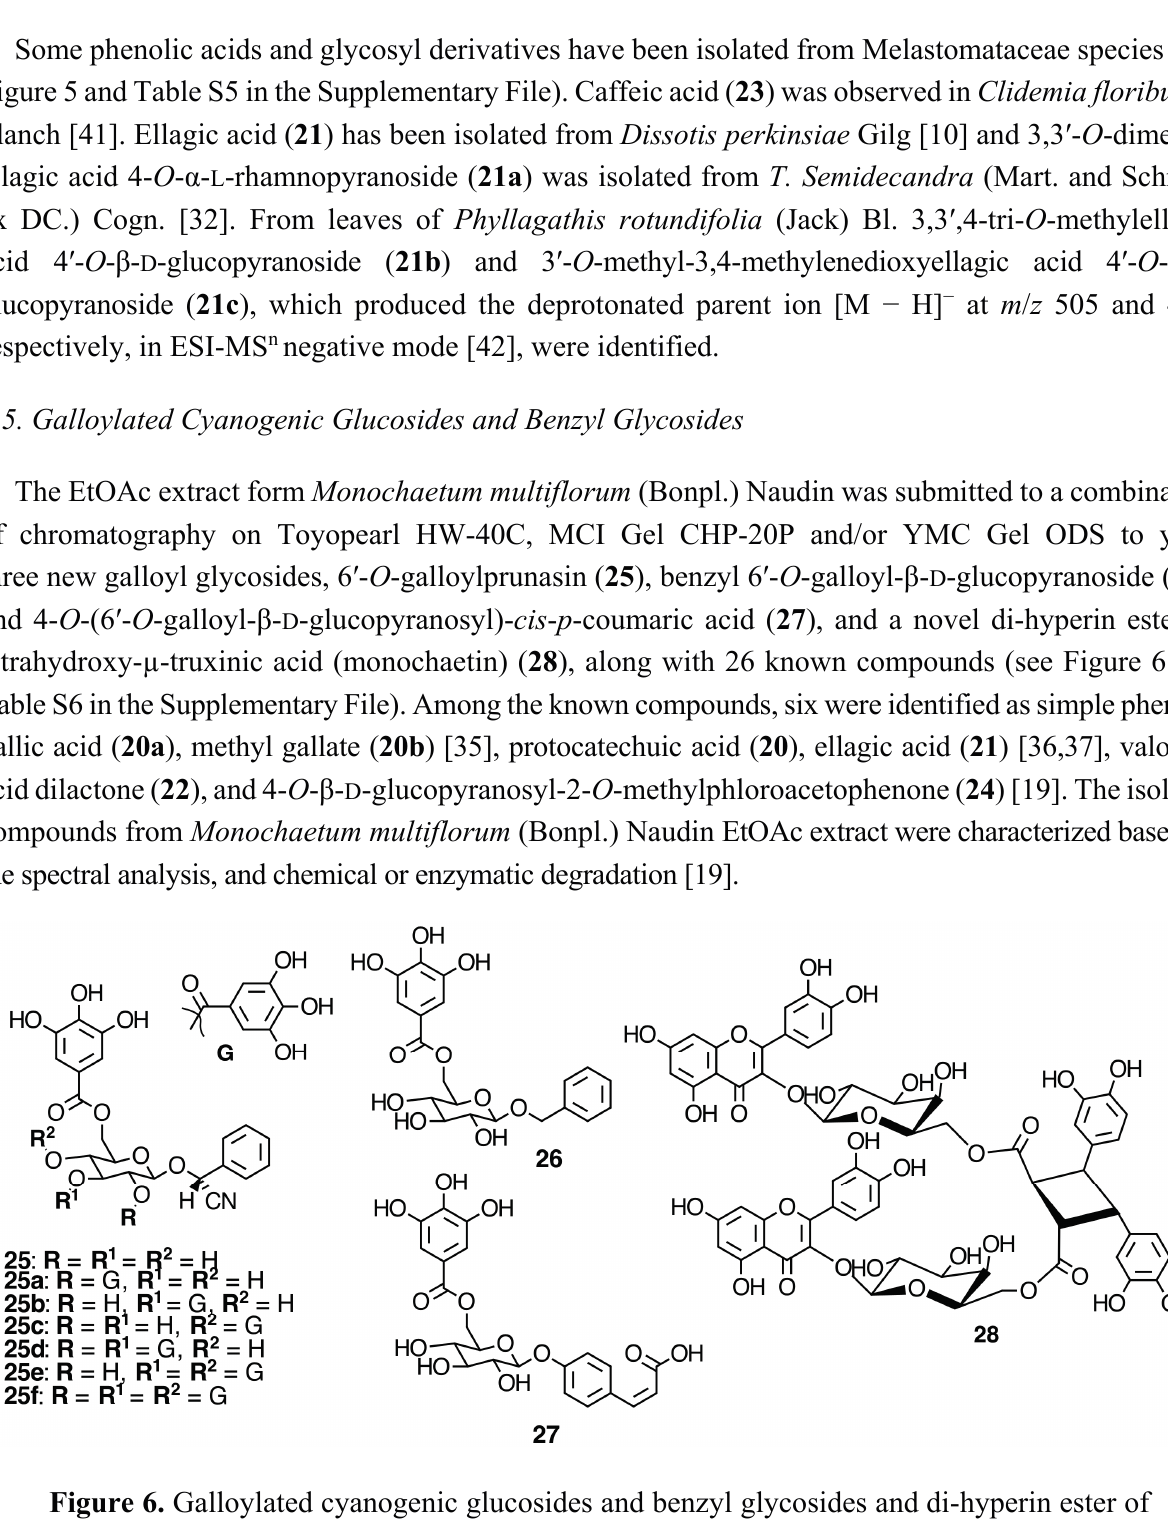
Figure 6. Galloylated cyanogenic glucosides and benzyl glycosides and di-hyperin ester